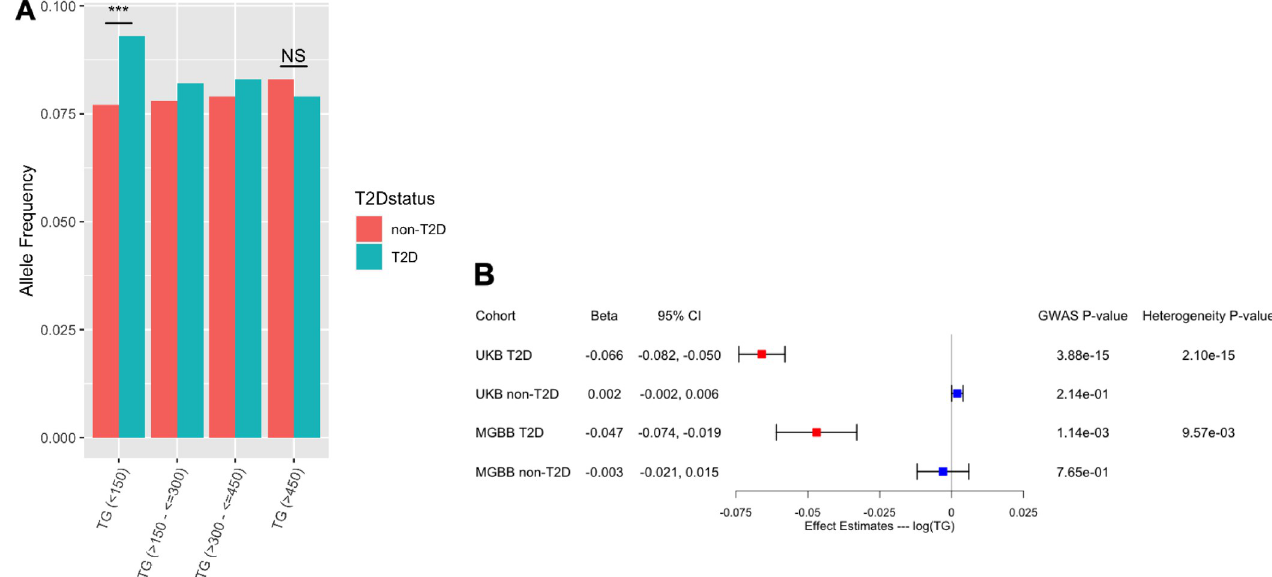
Fig 2. HLA-DQB1/DQA2 rs9274619:A significantly interacts with T2D on triglycerides. A) Allele frequency of rs9274619:A in T2D and non-T2D samples grouped by raw TG values. Significance of samples proportions between the groups was assessed using Fisher’s exact test for the lower and higher TG bins. B) GWAS and heterogeneity statistics of the lead variant rs9274619:A at the HLA-DQB1/DQA2 locus from discovery (UKB) and replication (MGBB) cohorts based on T2D stratification. CI–Confidence Intervals; GWAS–Genome wide association studies; HLA–Human Leukocyte Antigens; MGBB–Mass General Brigham Biobank; NS–Non Significant; T2D –Type 2 Diabetes; TG–Triglycerides; UKB–UK Biobank.